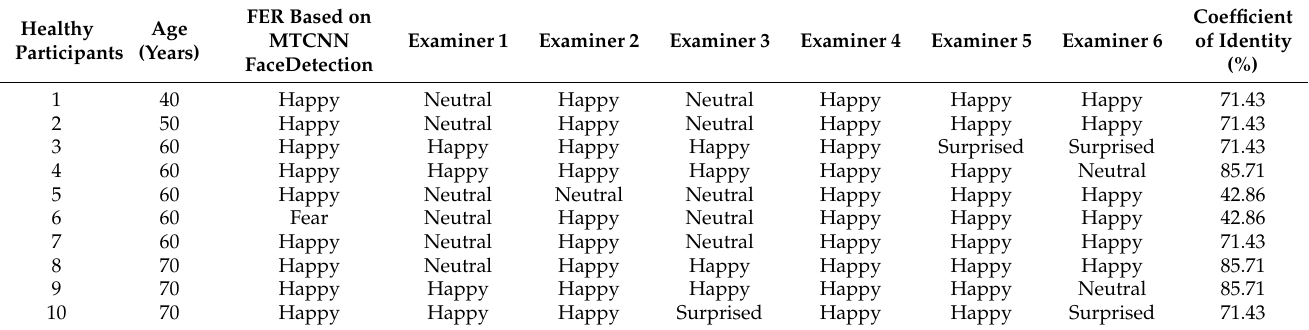
Table 1. Agreement rate and kappa coefficients between the subjective FER from the six examiners for the smiles of 10 healthy participants and FER based on MTCNN face